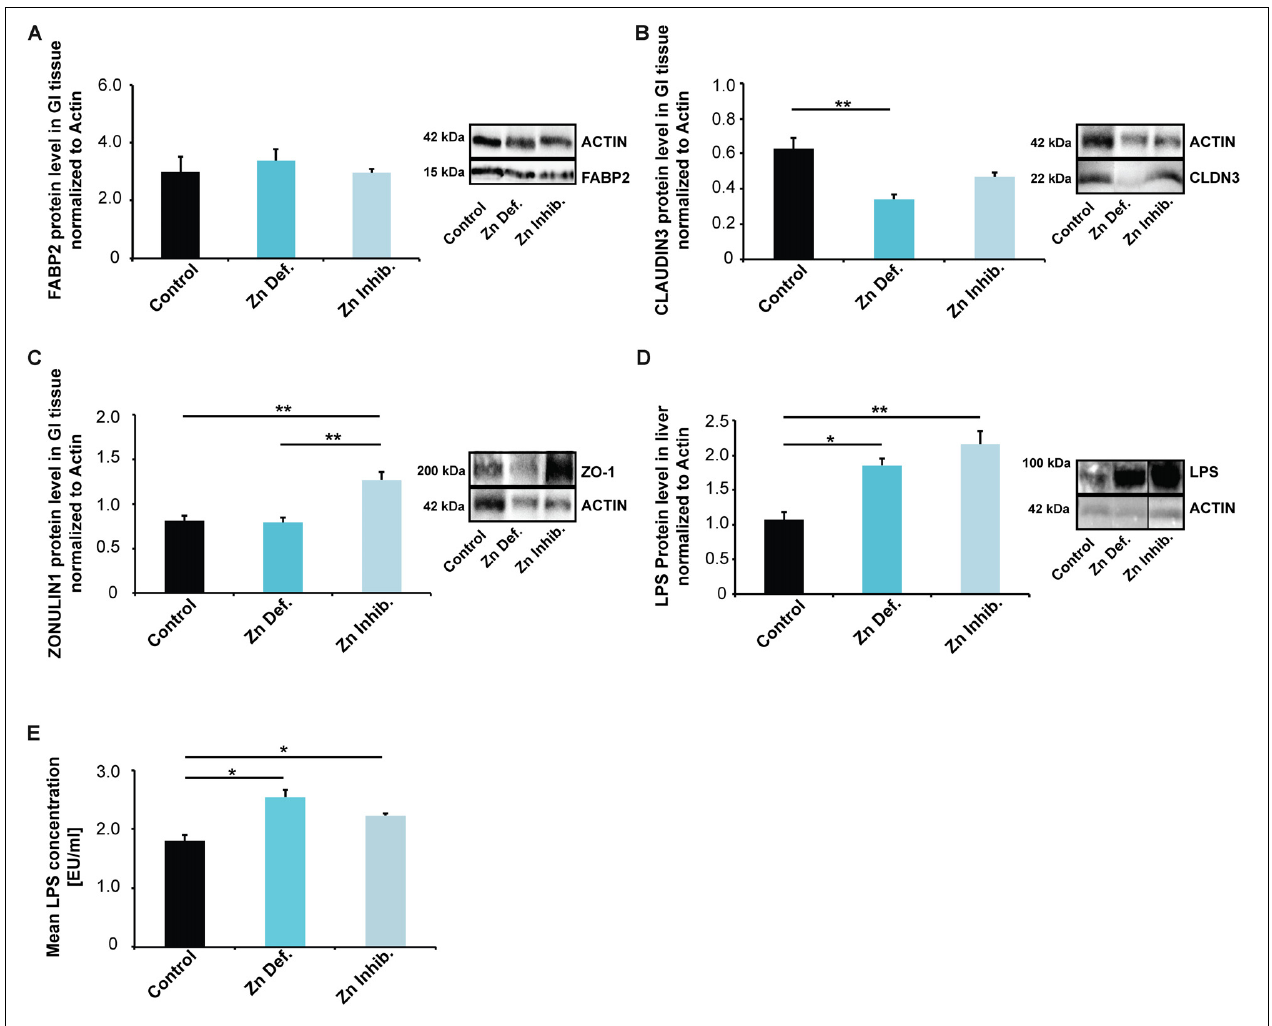
FIGURE 3 | (A–C) Gastro-intestinal epithelium was isolated from three mice per group and protein lysates analyzed using Western blotting. (A) No significant differences in FABP2 were detected. (B) Mice on a Zn deficient diet had significantly reduced levels of CLAUDIN3. (C) ZONULIN1 was significantly increased in mice on Zn inhibitor diet. (D) Liver tissue was isolated from three mice per group and protein lysates analyzed for the levels of E. coli lipopolysaccharide (LPS) using Western blotting. A significant increase in liver LPS is visible in mice on a Zn deficient and Zn inhibitor diet. (E) LPS levels were measured by LAL assay from three mice per group in triplicates. The results show significantly increased LPS levels in liver lysate from mice on Zn deficient and Zn inhibitor diet compared to controls.